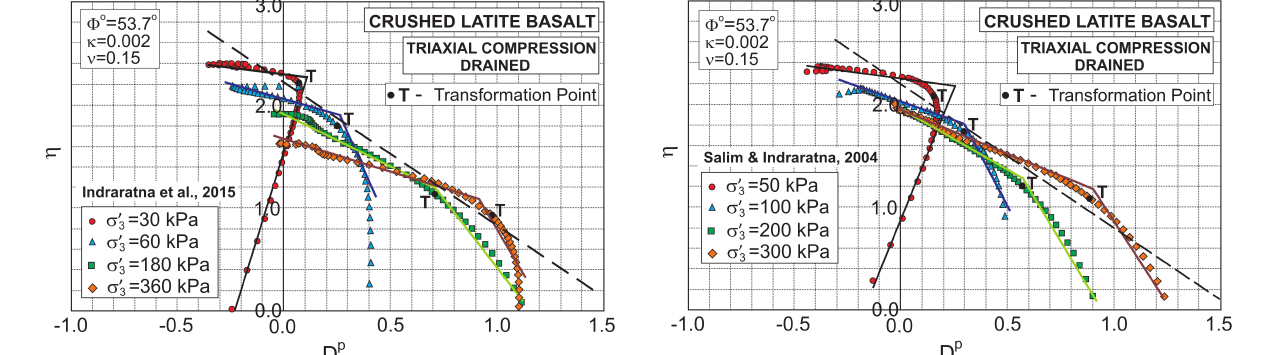
Figure 2: The relationships η-D p for crushed latite basalt.